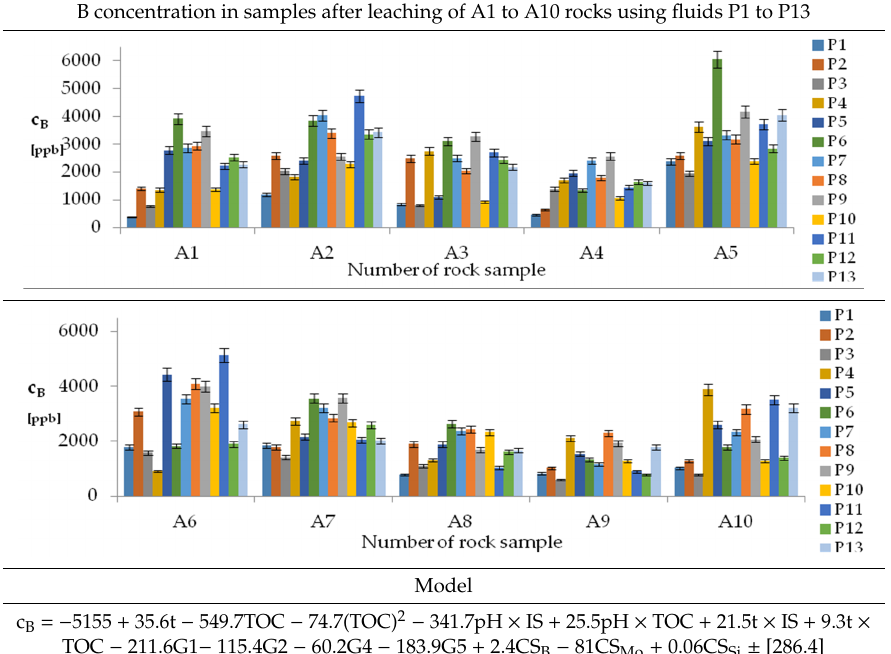
Table 5. Results of leaching samples A1 to A10 rocks using fluids P1 to P13 for Boron (B). B concentration in samples after leaching of A1 to A10 rocks using fluids P1 to P13